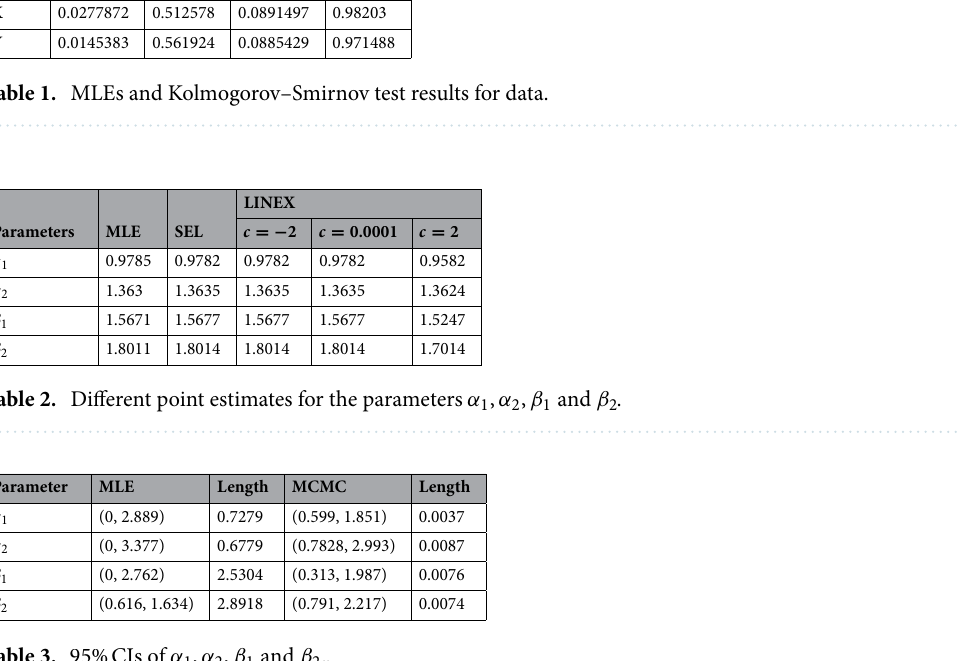
Table 3. 95% CIs of α 1 , α 2 , β 1 and β 2 .